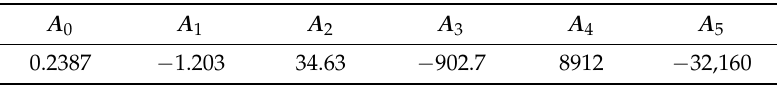
Figure 5. Radome structure: ( a ) Geometric median cross section of the radome; ( b ) internal photo of the manufactured radome. Table 1. The polynomial coefficients of Equation (21).